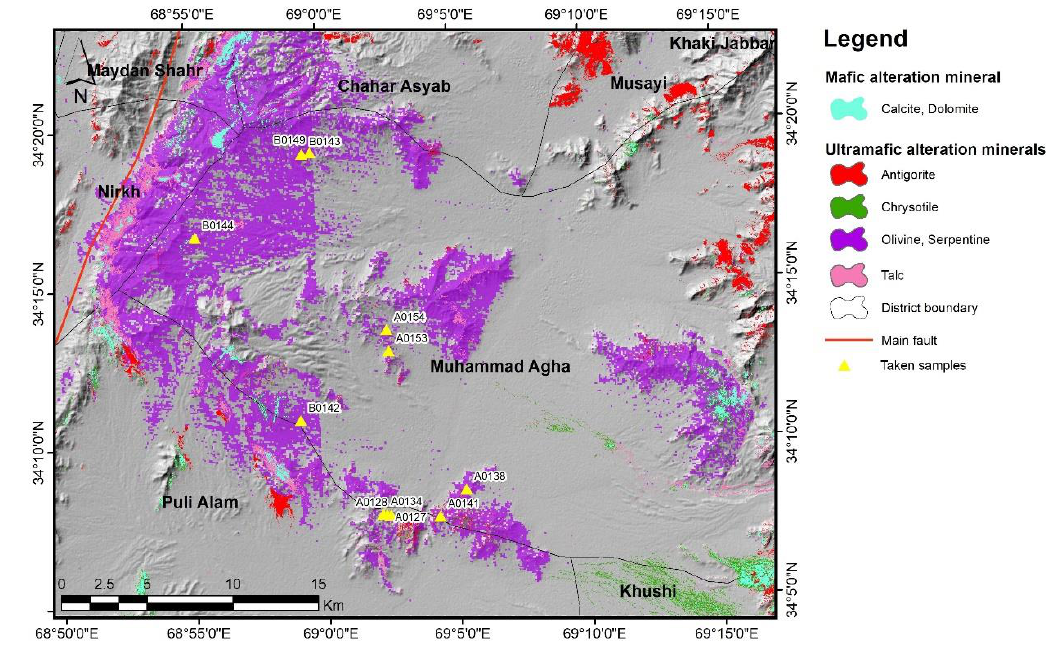
Figure 8. Combination of the classified thematic map using SAM, MI, and BR showing the distribution of the selected mafic–ultramafic minerals.